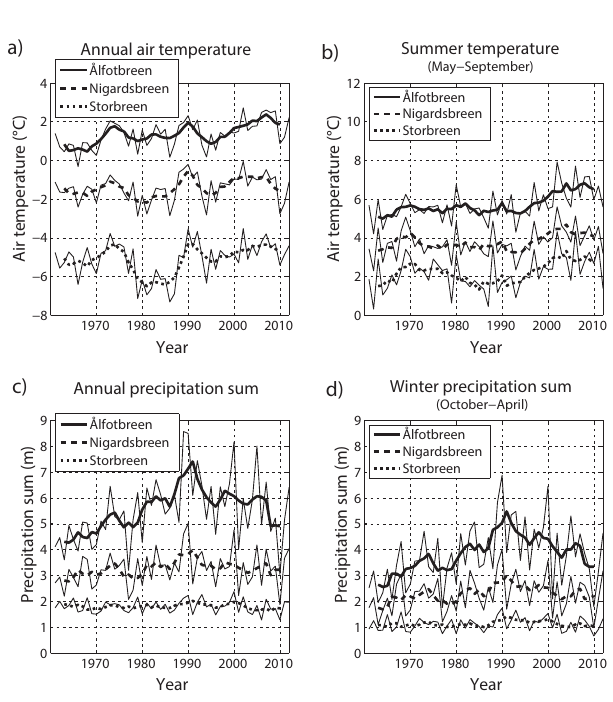
Fig.2. Airtemperatureandprecipitationdatawith5-yearmovingaveragesforthethreecatchmentsbasedon seNorge data. Fig. 2. Air temperature and precipitation data with 5yr moving av- erages for the three catchments based on seNorge